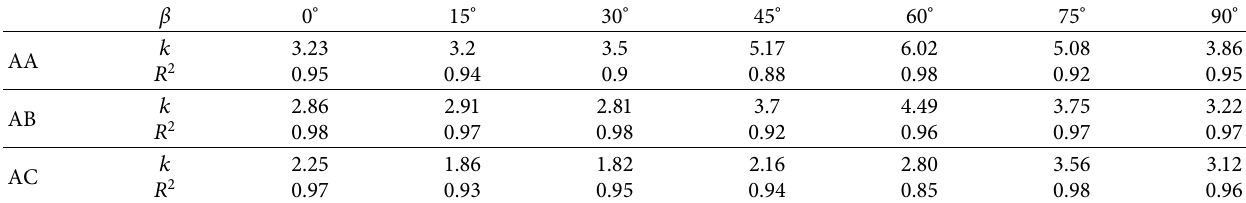
Figure 12: Fitting curve of the linear Mohr–Coulomb strength criterion. (a) Group AA, (b) Group AB, and (c) Group AC. Table 3: The calculated coefficients of the Mohr–Coulomb criteria for different groups of rocks.